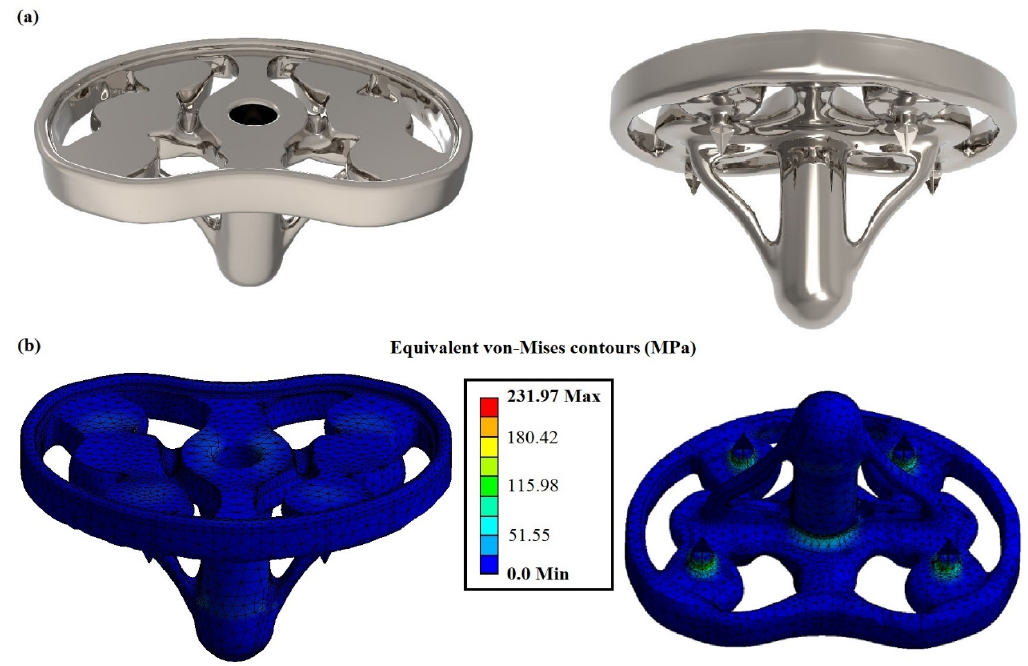
Figure 6. ( a ) Rendered images of the density-based topologically optimized tibial implant; ( b ) Con- tours of the density-based topologically optimized tibial implant for equivalent von Mises stress.